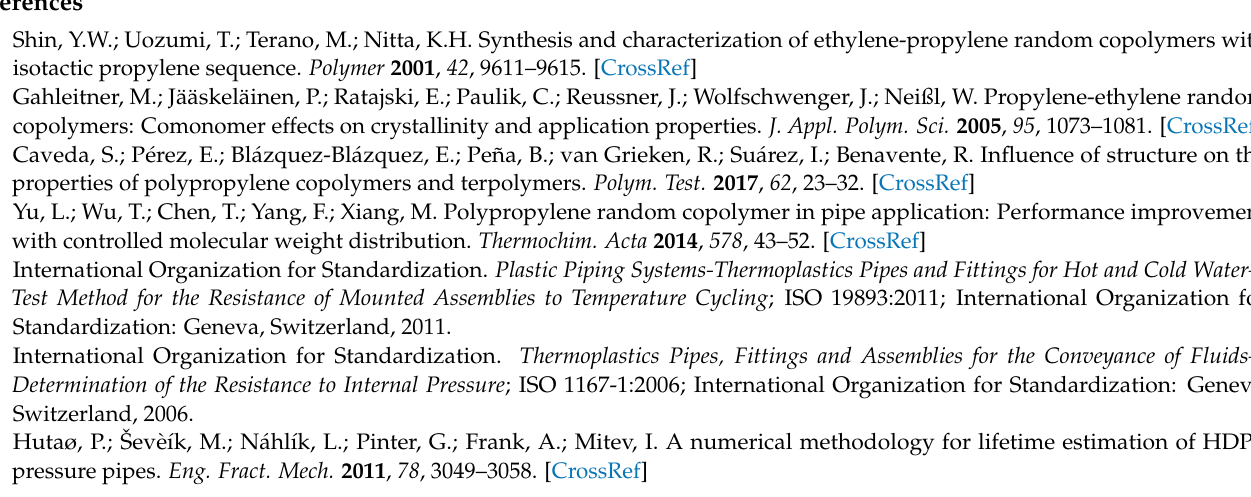
Table S2: Data from